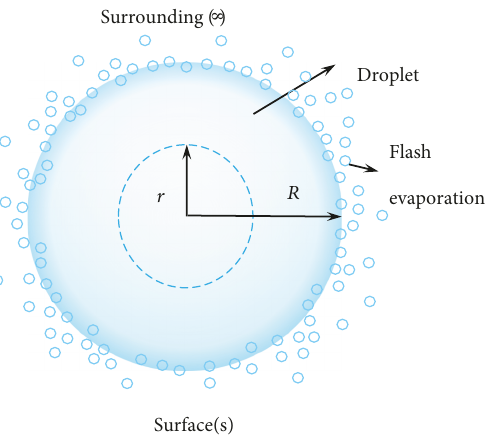
Figure 2: Single-droplet evaporation model.